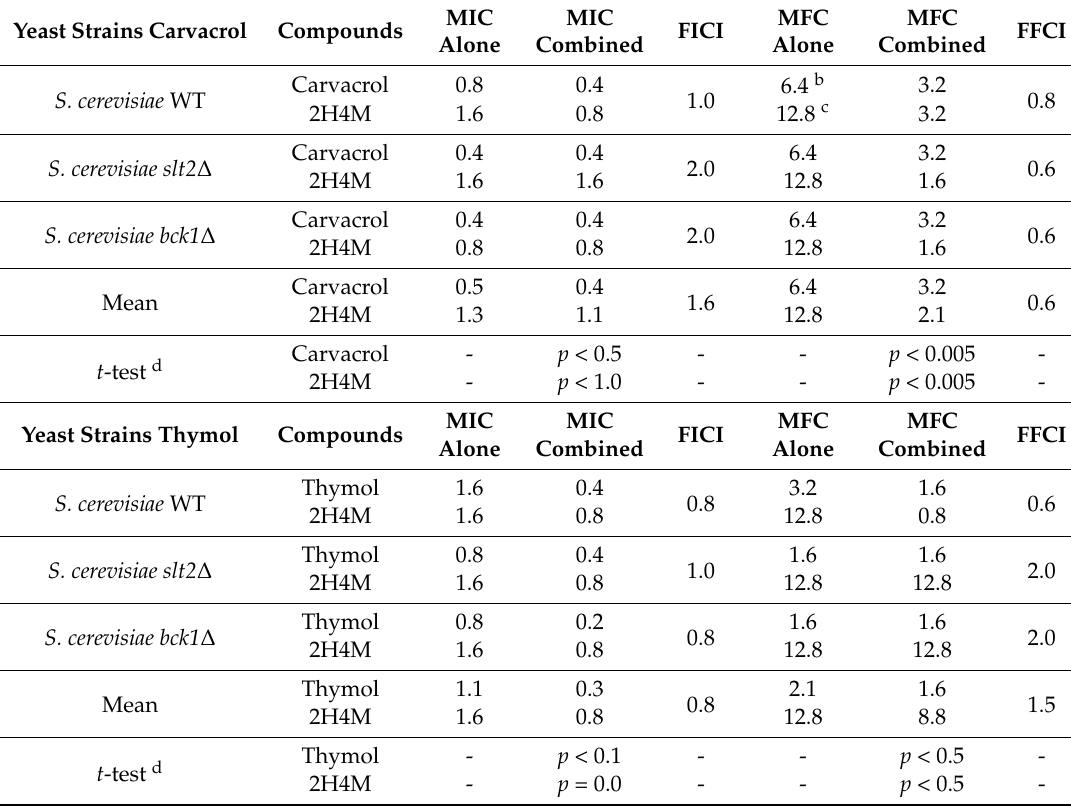
Table 4. Antifungal chemosensitization of 2H4M (mM) to carvacrol or thymol (mM), tested